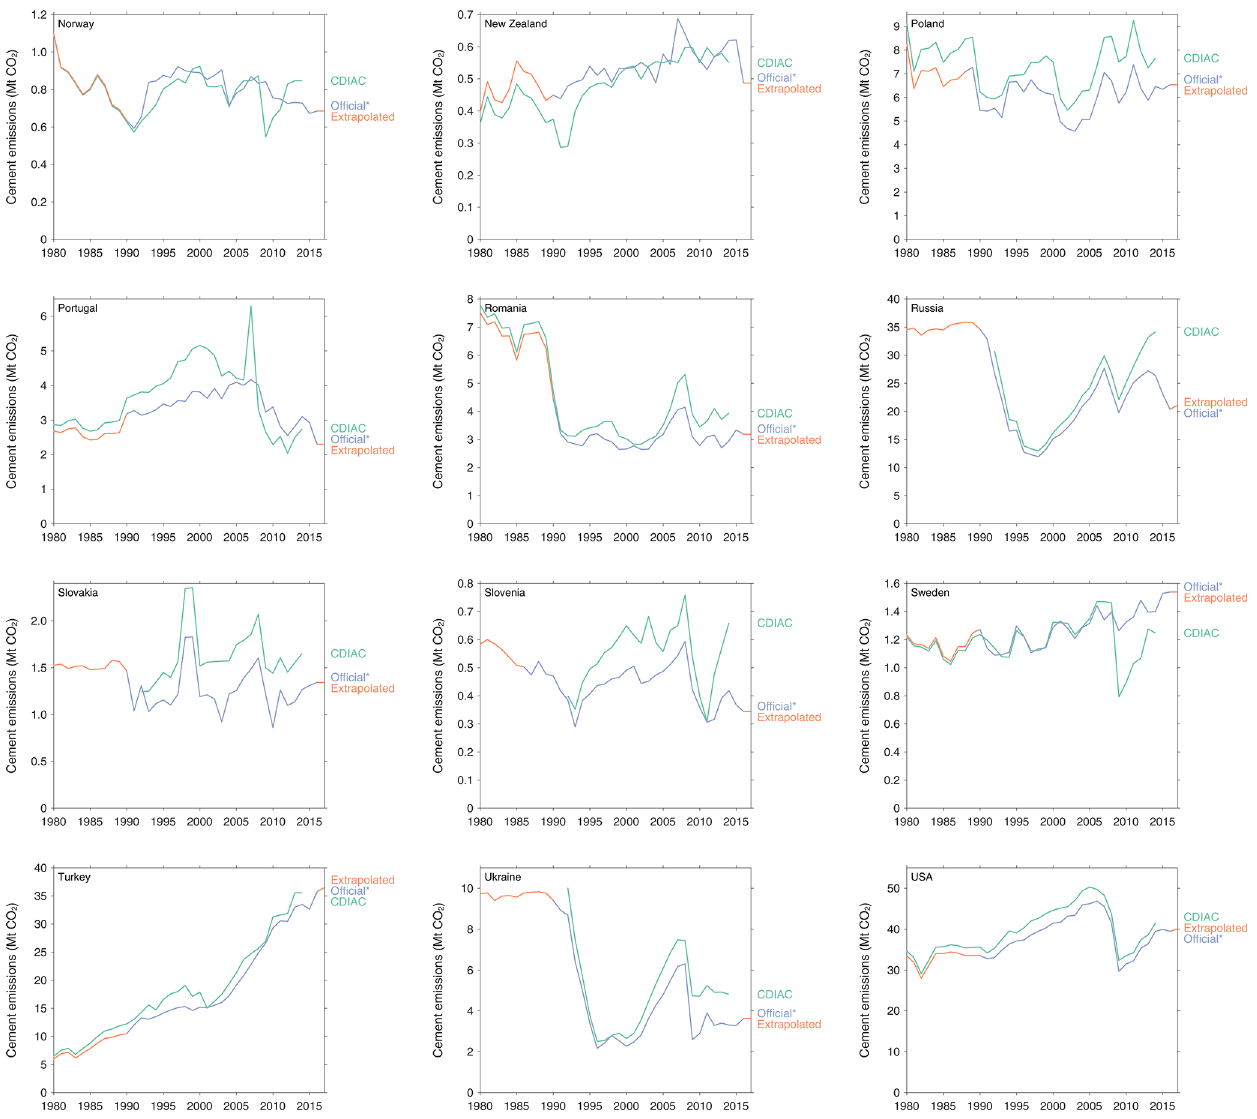
Figure C1. Revised cement emissions for Annex-I parties to the